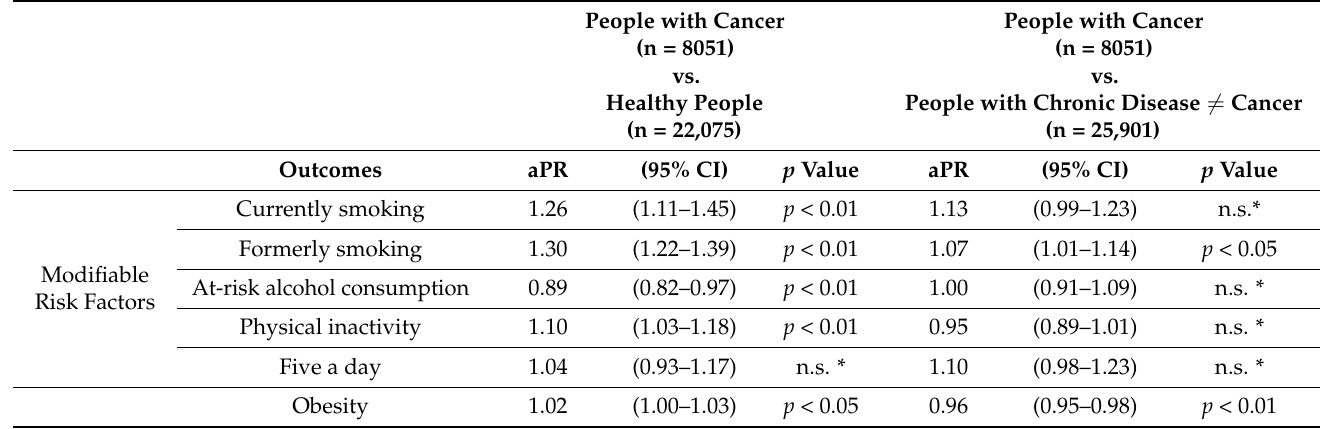
Table 4. Modifiable risk factors among people aged ≥ 65 years with cancer compared to people with chronic disease other than cancer and healthy individuals. Passi d’Argento 2016–2019 (n = 56,027). Adjusted prevalence ratios–aPRs (by Poisson regression models) for age, gender, educational level, economic difficulties and regional macroarea with corresponding 95% confidence intervals (95% CI) and p -value. People with Cancer People with Cancer (n = 8051) (n = 8051) vs. vs. People with Chronic Disease (cid:54) = Cancer Healthy People (n = 25,901) (n = 22,075) aPR (95% CI) p Value p